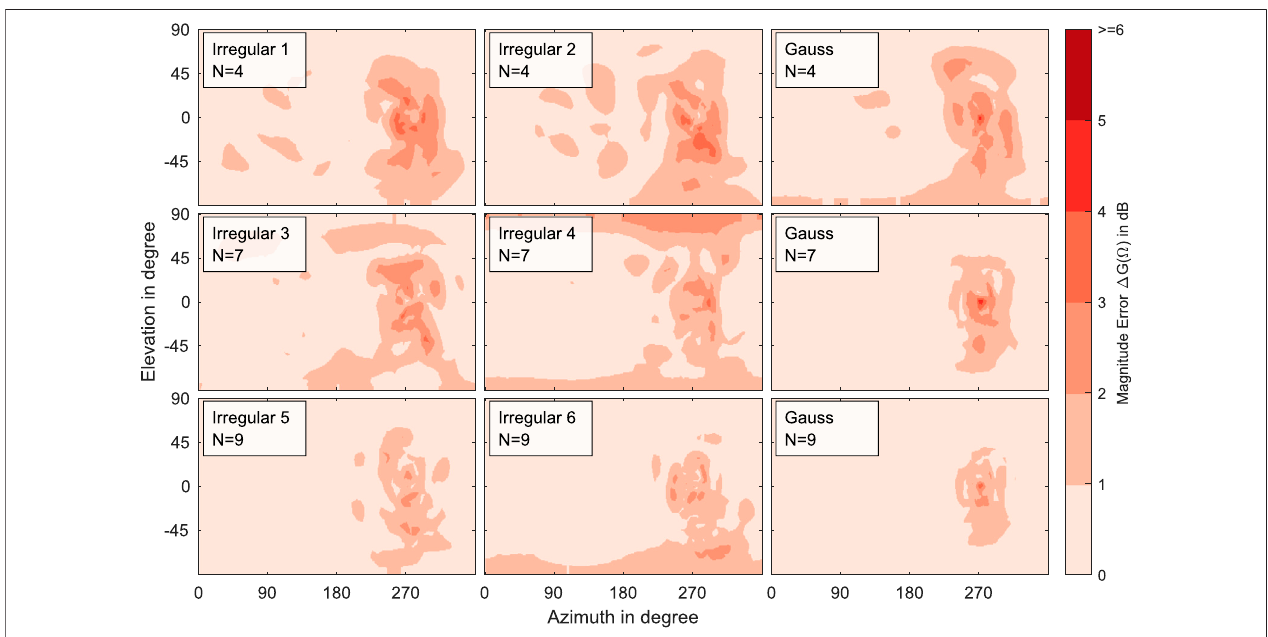
FIGURE 8 | Left-ear magnitude error Δ G ( Ω ) for six examined irregular grids and three regular Gauss grids, with estimated optimal (irregular) or corresponding (regular) SH order. HRTF: Subject no. 10 from HUTUBS database.